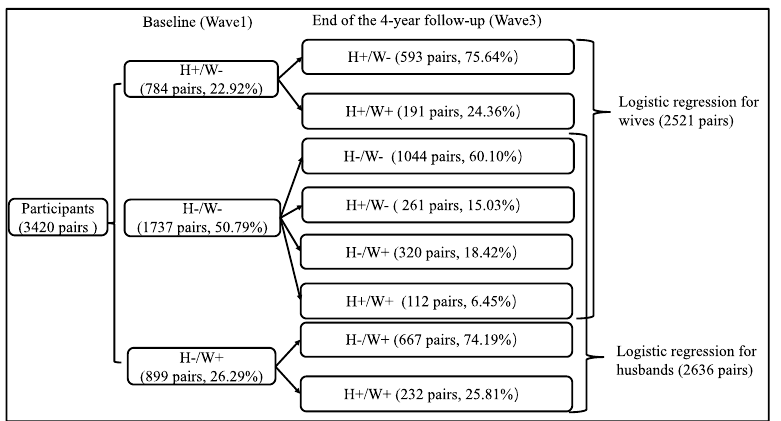
Figure 1. Flowchart of chronic disease development from baseline to 4-year follow-up among couples. Notes. H: husbands; W: wives; -: no chronic diseases; +: with chronic